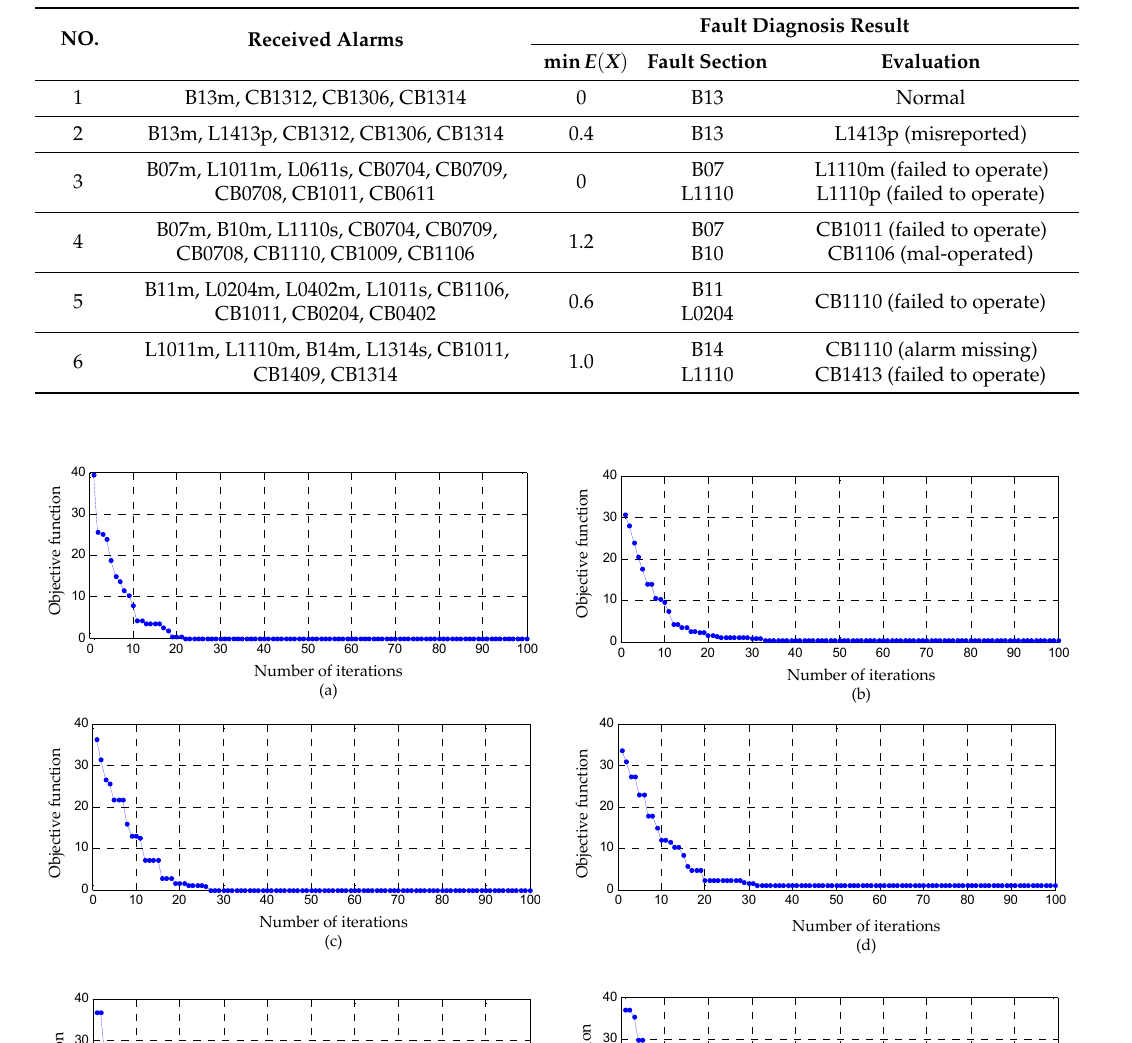
Table 1. Case studies of the IEEE 14-bus system.